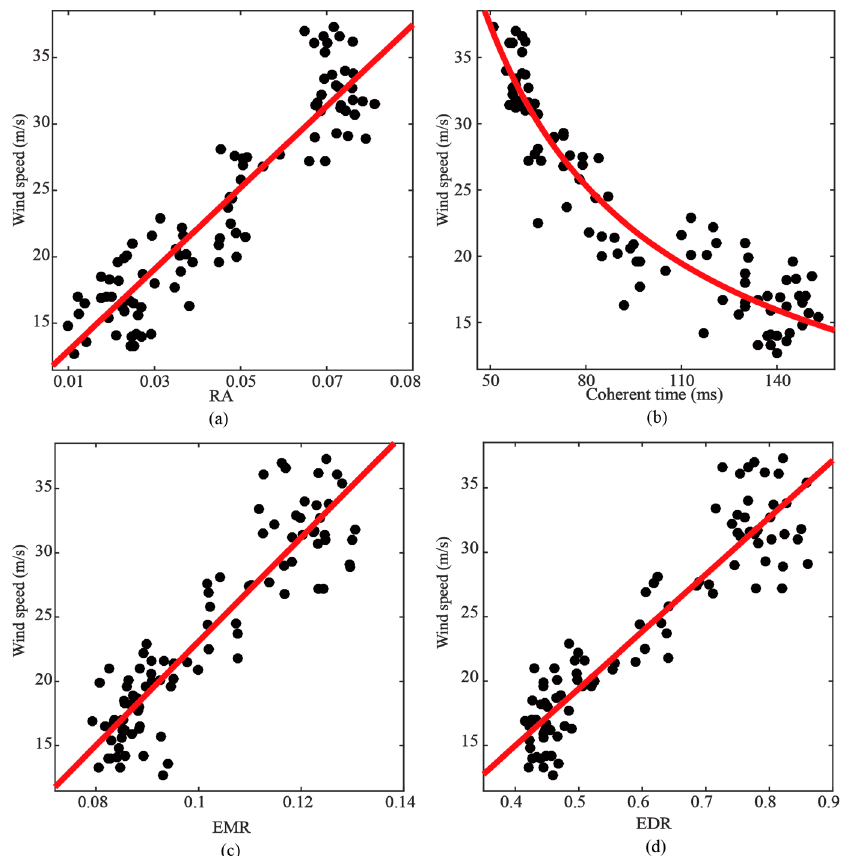
2 0.25 Threshold = . The